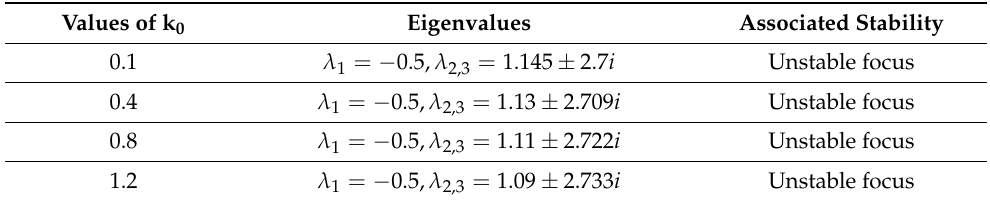
Table 1. Eigenvalues of the tabu learning neuron with their corresponding stability for some discrete values of the parameter k 0 around the